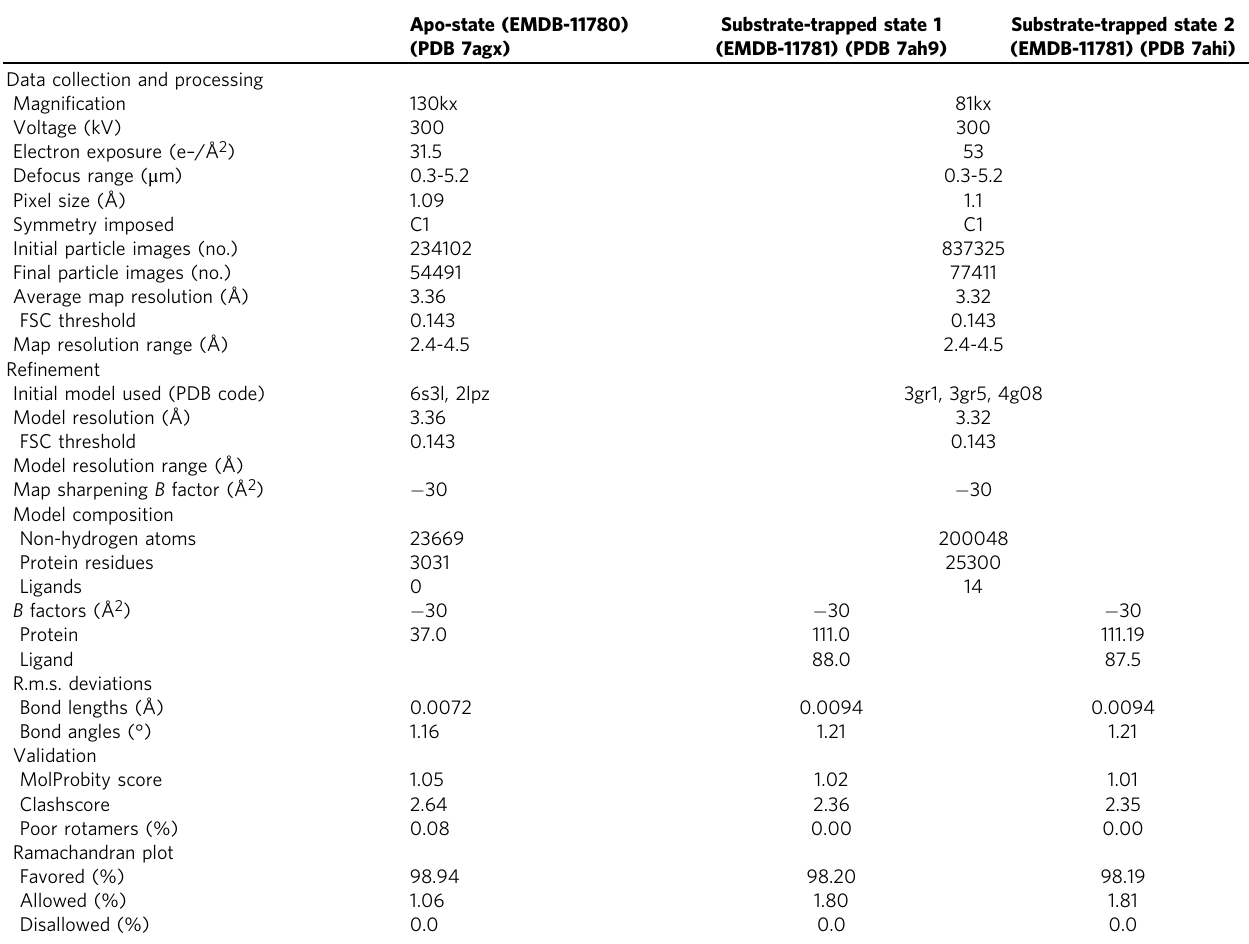
Table 1 Cryo-EM data collection, re fi nement, and validation